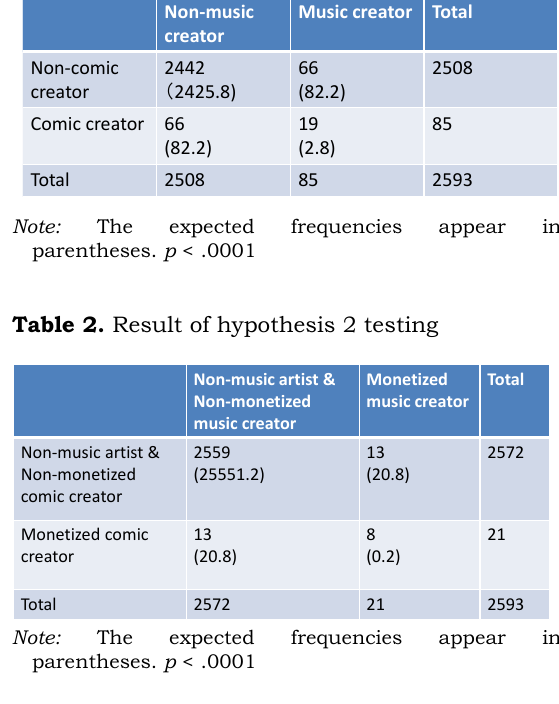
Table 3. Result of hypothesis 3